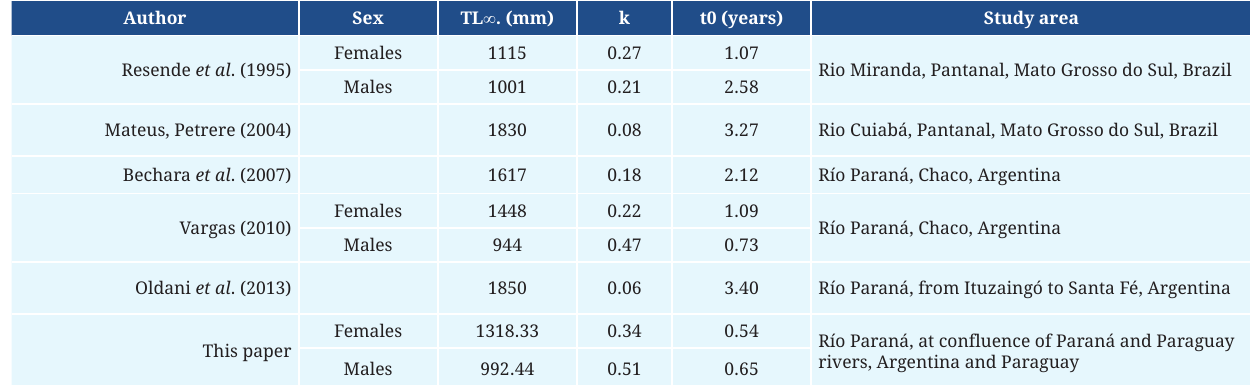
TABLE 4 | Parameters of the von Bertalanffy curve obtained by different authors for Pseudoplatystoma corruscans and those corresponding to this